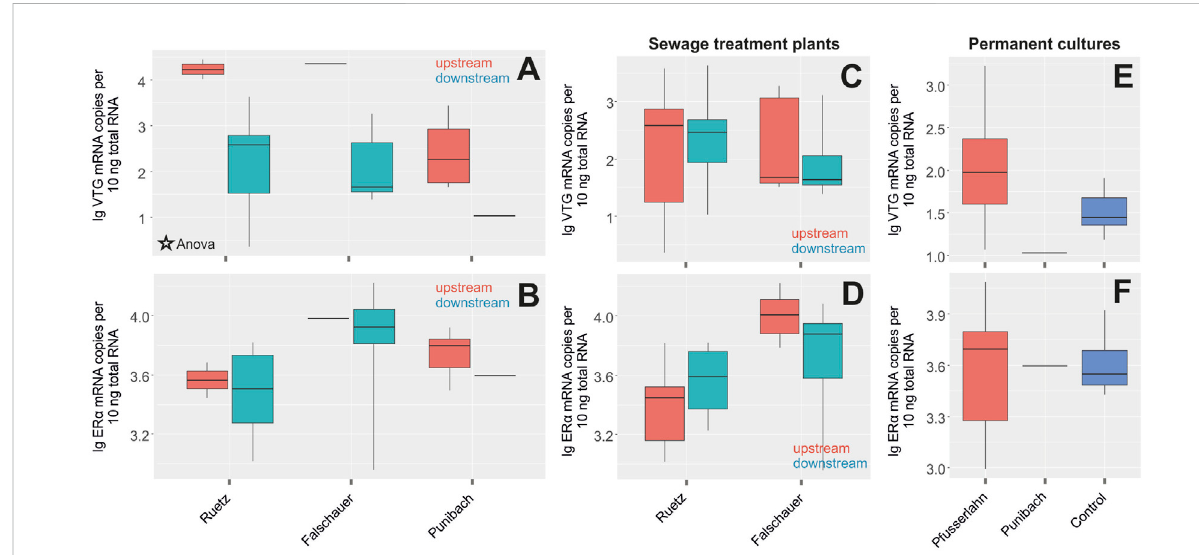
FIGURE 5 Log transformed expression levels (mRNA copy numbers per 10 ng total RNA) of (A) vitellogenin (VTG) (ANOVA; p = 0.0009), (B) estrogen receptor α (ER α )inlivertissuesofmale (turquoise)andfemale(red)individualsof S.trutta farioattherespectivesamplingsites.Signi fi cantdifferences of mRNA expression between males and females were con fi rmed by ANOVA ( p ≤ 0.001). Log transformed expression levels (mRNA copy numbers per 10 ng total RNA) of (C) VTG, (D) ER α in liver tissues of control individuals upstream of a sewage treatment plant (red) and